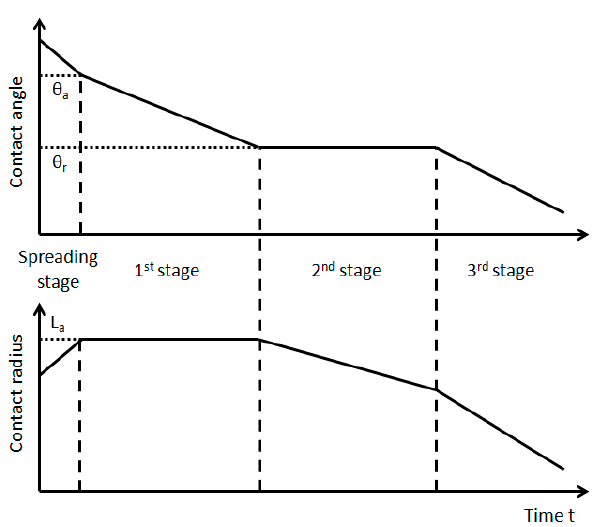
Figure 1. Scheme of the time evolution of the contact angle and the droplet radius during the different stages of the evaporation.